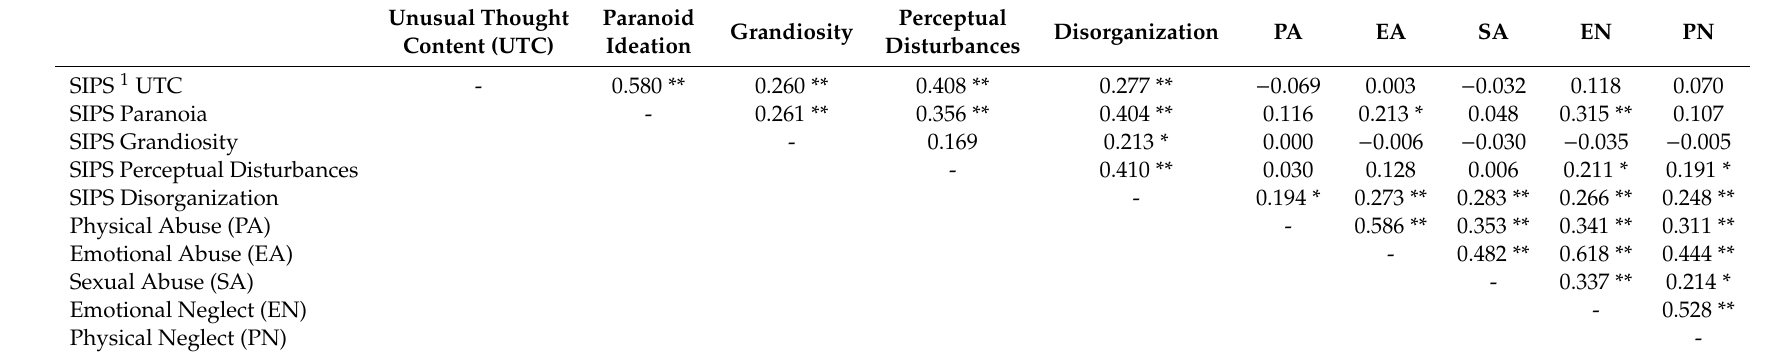
Table 2. Correlations of all attenuated symptom variables and all trauma variables ( n =